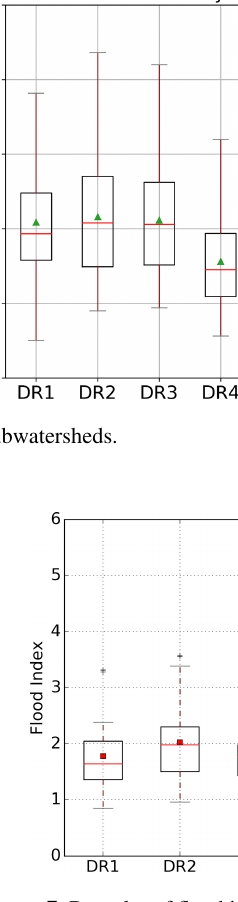
Figure 7. Box plot of flood index across the DR subwatersheds for the 100-year design